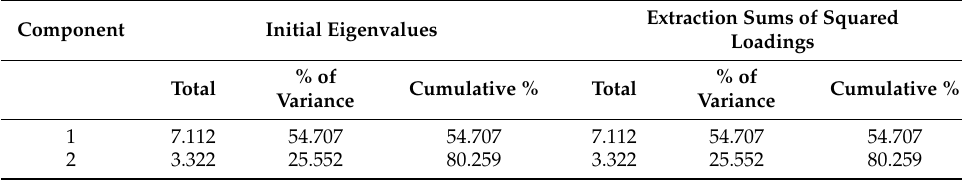
Table 2. Total variance